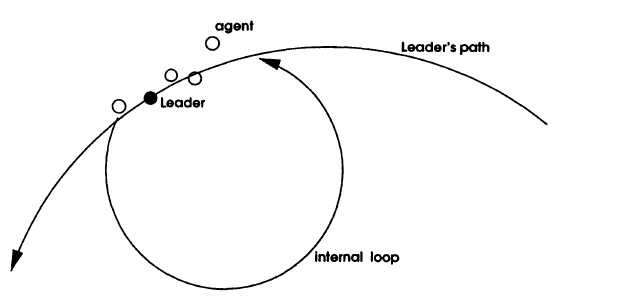
FIGURE 2 An illustration of the loop internal to the leader’s path performed by an ordinary